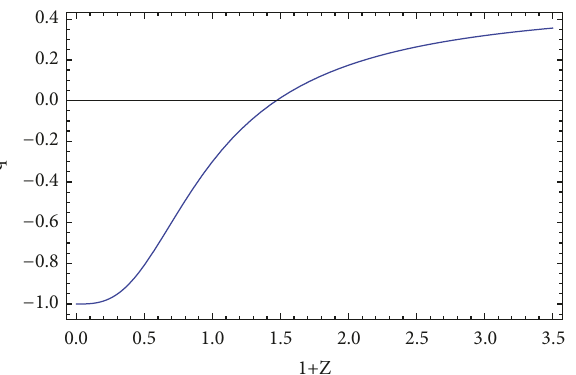
Figure 3: The evolution of the deceleration parameter 𝑞 versus redshift parameter 𝑧 for noninteracting GDE in DGP model. Here, we have = 0.0003 . taken Ω 𝐷 (𝑧 = 0) = 0.73 , 𝐻(𝑧 = 0) = 67 , and Ω 𝑟 𝑐